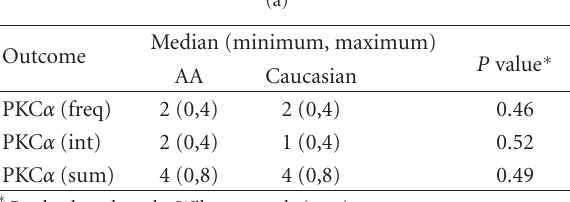
Table 2: (a) PKC α expression is similar in African American and Caucasian patients. (b) ER β expression and subcellular localization is similar in African American and Caucasian